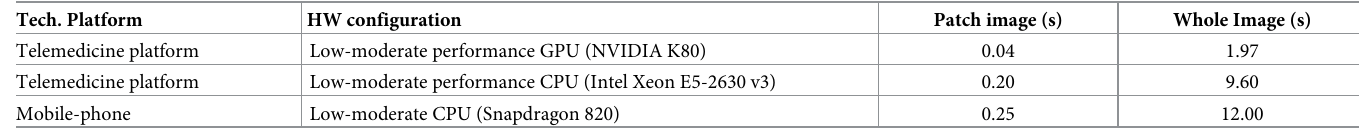
Table 4. Comparison of the time needed to execute the AI algorithm with different technological platforms and hardware configurations. Tech.